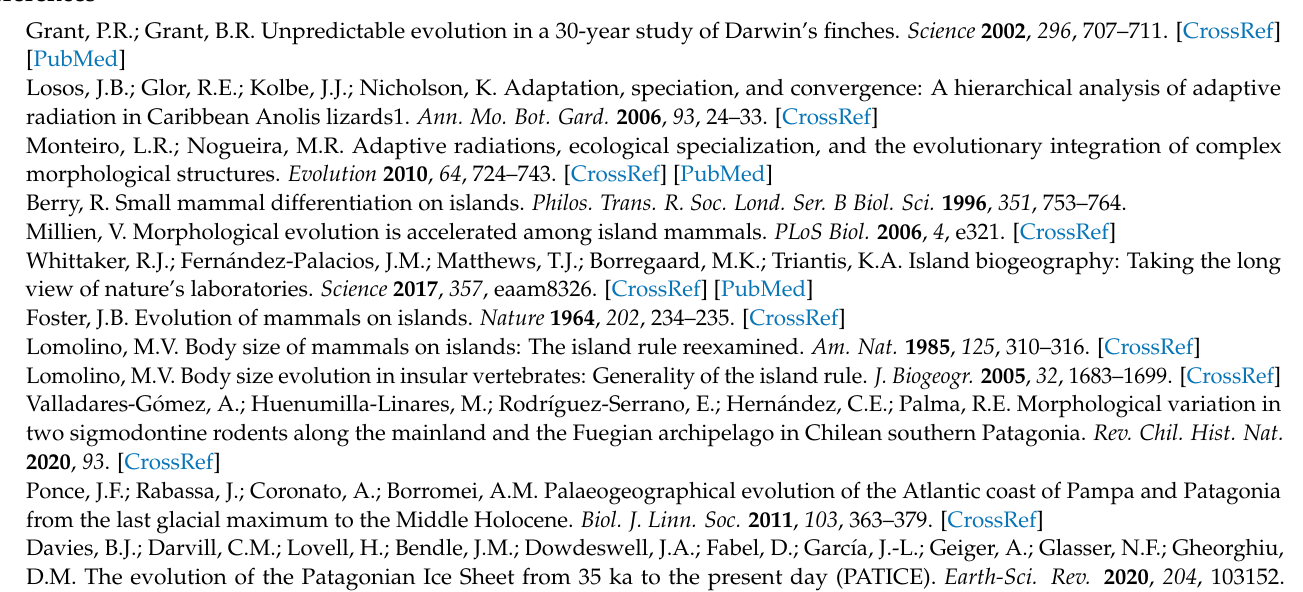
analysis, Table S2. Eingeenvalues, Principal componente analyses, Table S3. Results of T analyses, Table S4. Discriminant analysis with multivariate geometric morphometrics data. Left side., Table S5. Discriminant analysis with multivariate geometric mophometrics data. Right side, Table S6. Dis- criminant analyses with linear measurements. Left side, Table S7. Discriminant analyses with linear measurements. Right side, Figure S1. Multivariate regression, Figure S2. Ressidual matriz, Principal component analysis